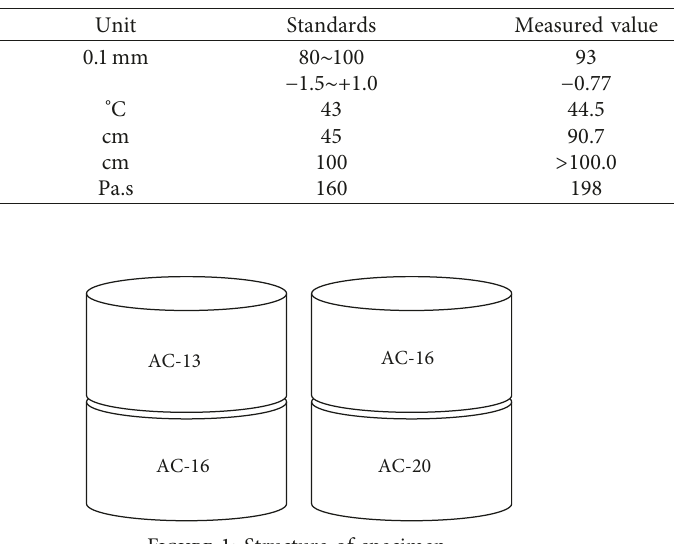
Table 1: Performance index of virgin asphalt (90#).